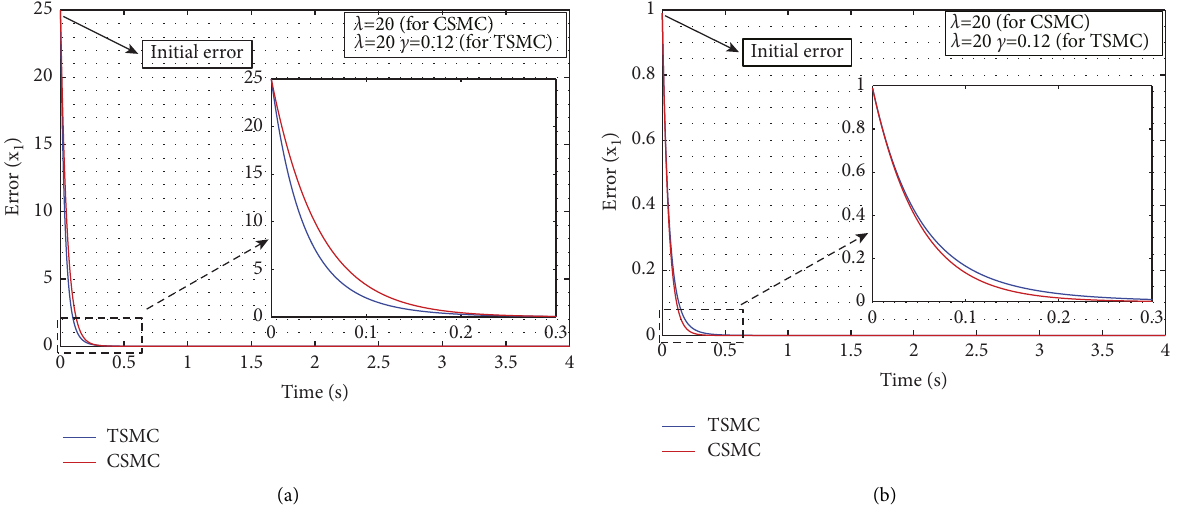
Figure 4: Error trajectory of TSMC and CSMC: (a) far away initial value; (b) near initial value.